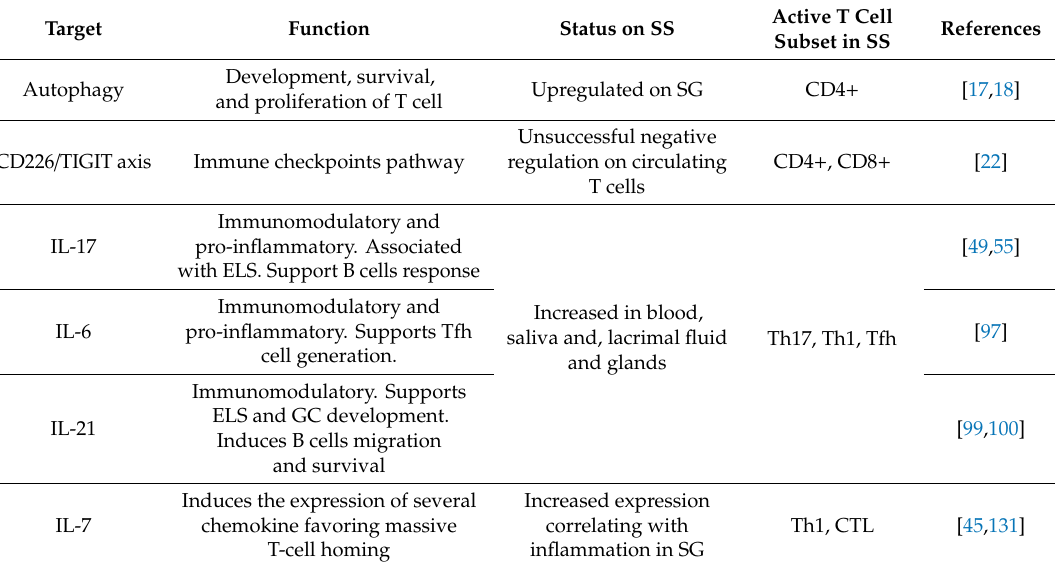
Table 1. Potential molecular alternative targets for SS preclinical / clinical